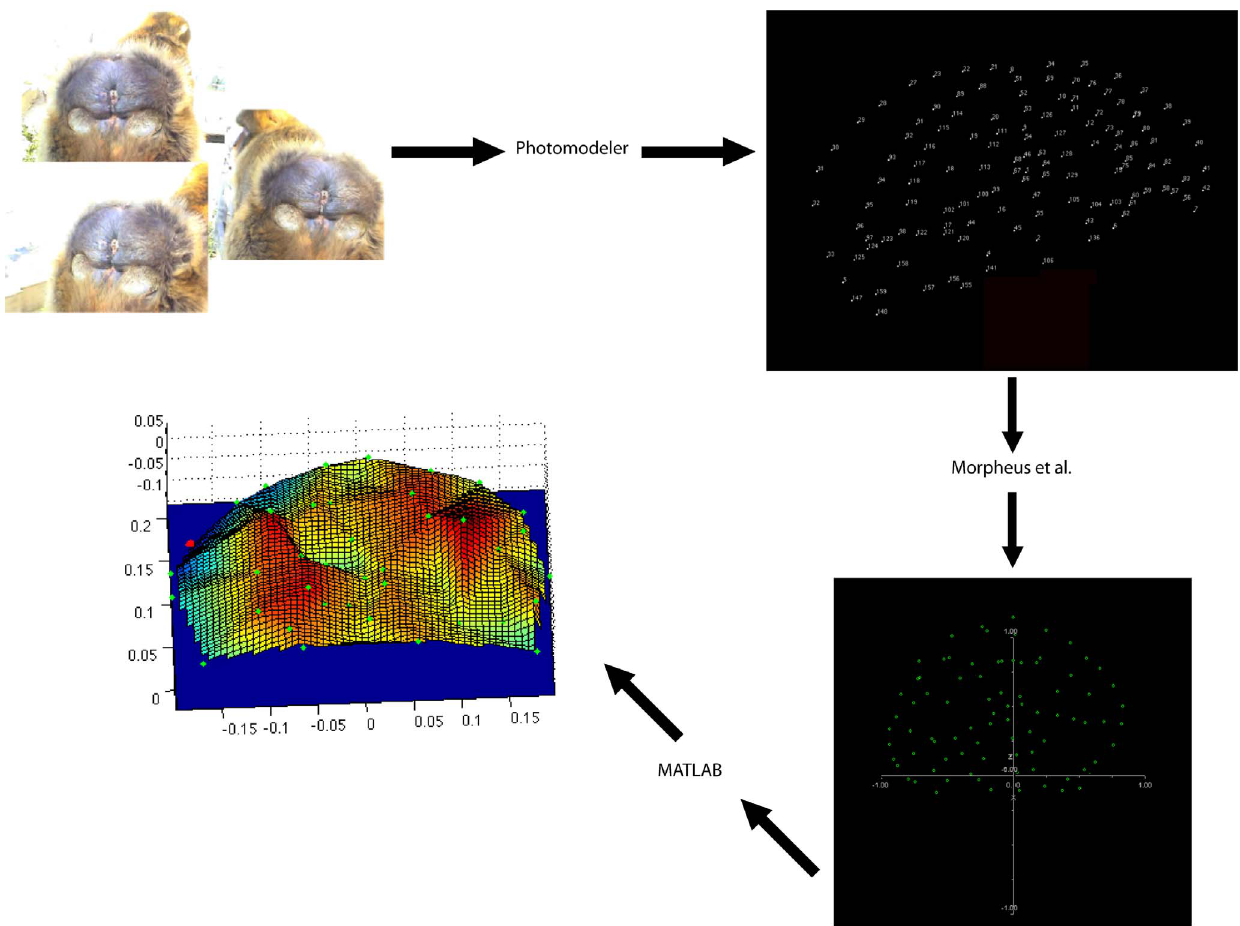
Figure 6. Workflow. This figure illustrates the workflow from image selection, through coordinate reconstructions, landmark-configuration alignment, and, finally, volume estimation.